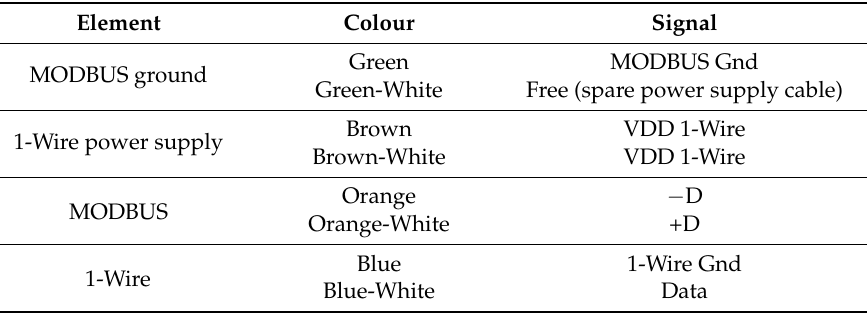
Table 2. Signal and colours distribution for cable A.